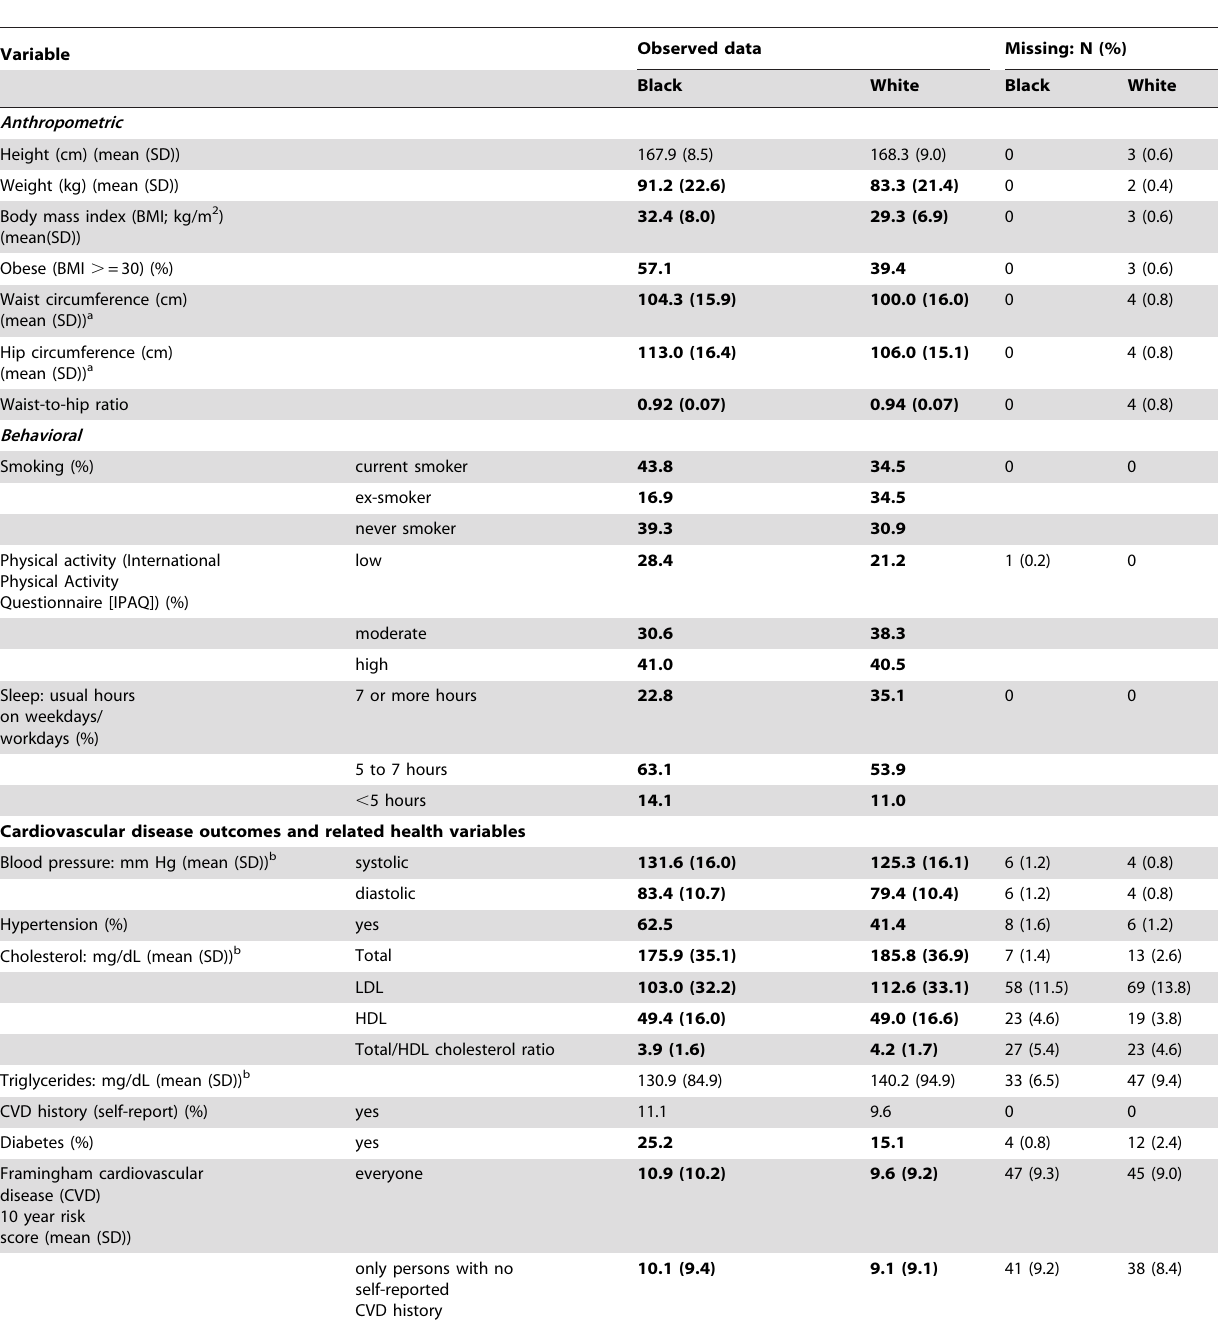
Table 3. My Body My Story study participants’ health-related characteristics: 504 black and 501 white community health center members, all US-born, non-Hispanic, ages 35–64 (Boston, MA, 2008–2010).